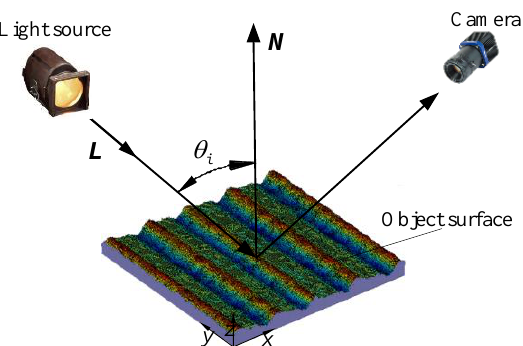
Figure 1. Shape from shading (SFS) model.